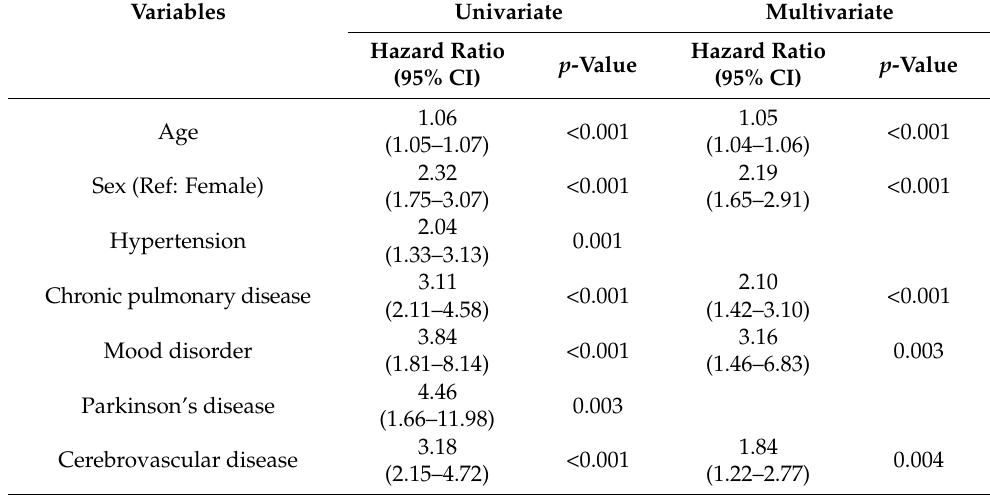
Table 3. Risk factors for postoperative pneumonia.